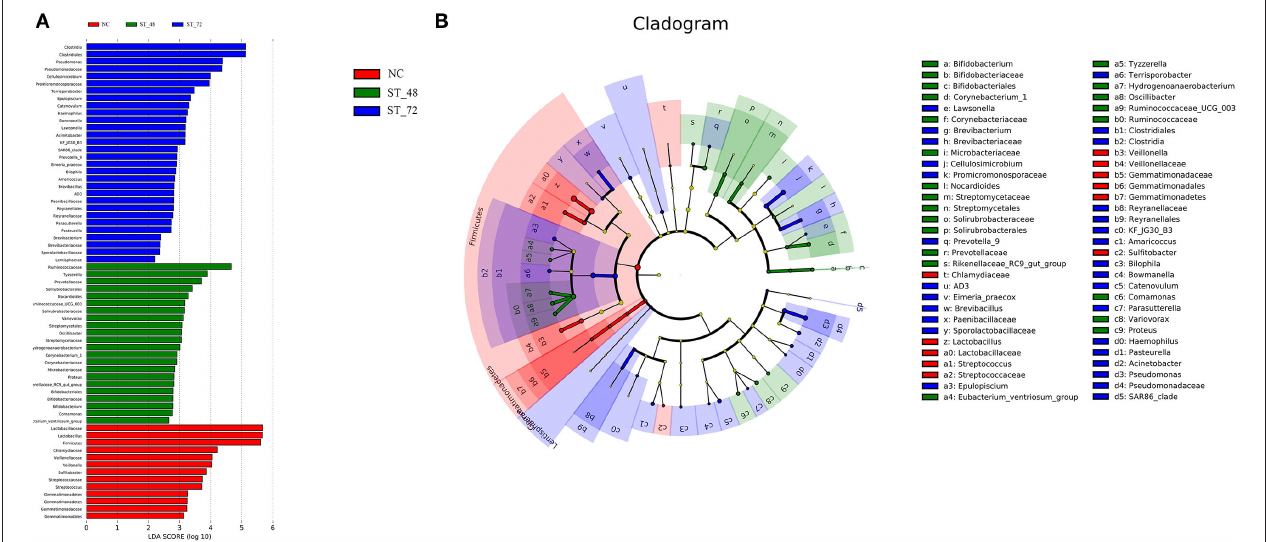
FIGURE 5 | Linear discriminant analysis effect size (LEFse) analysis of intestinal microbiota in piglets. LEFse identified the abundant taxa difference between the NC, ST_48, and ST_72 groups. At the phylum, family, and genus levels, the taxa enriched in NC are presented by a positive LDA score (red), those enriched in the ST_48 group are represented by a positive LDA score (green), and those enriched in the ST_72 group are represented by a positive LDA score (blue). Taxa with P < 0.05 and LDA > 2 are displayed. (A) LDA discriminant results map. (B) LEFse multilevel species hierarchical treemap.